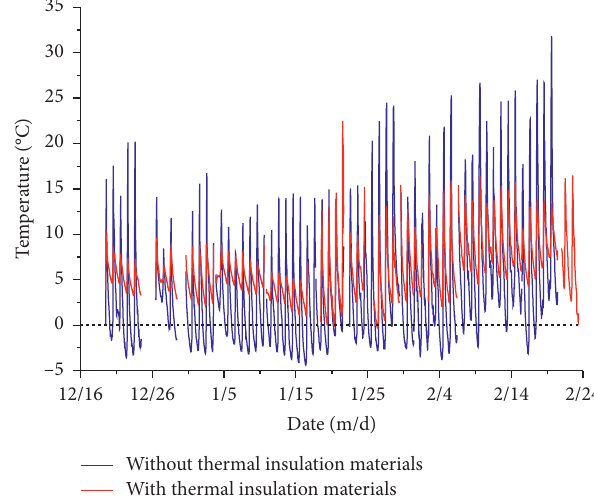
Figure 11: Variation of the ground surface temperature of the compacted gravelly soil with and without covering the thermal insulation materials on the dam core wall with time from December 18, 2016 to February 22,